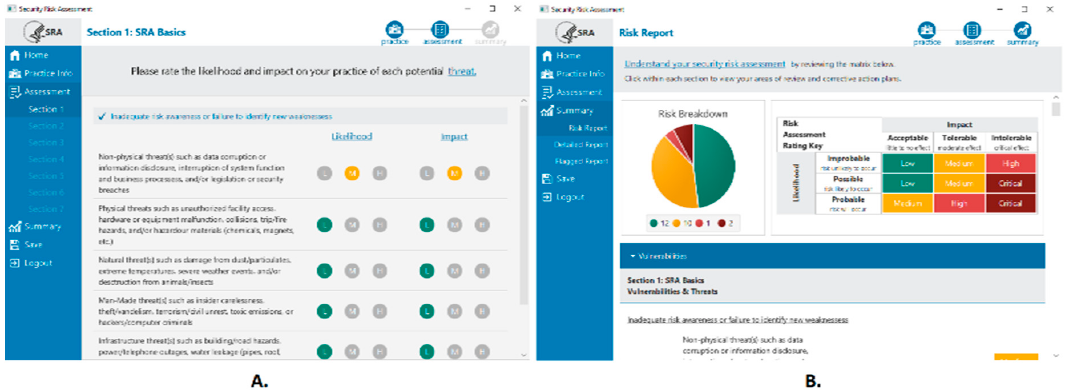
Figure 9. Smart home system evaluation with the SRA tool: ( A ) . intermediate steps, ( B ) . final report.